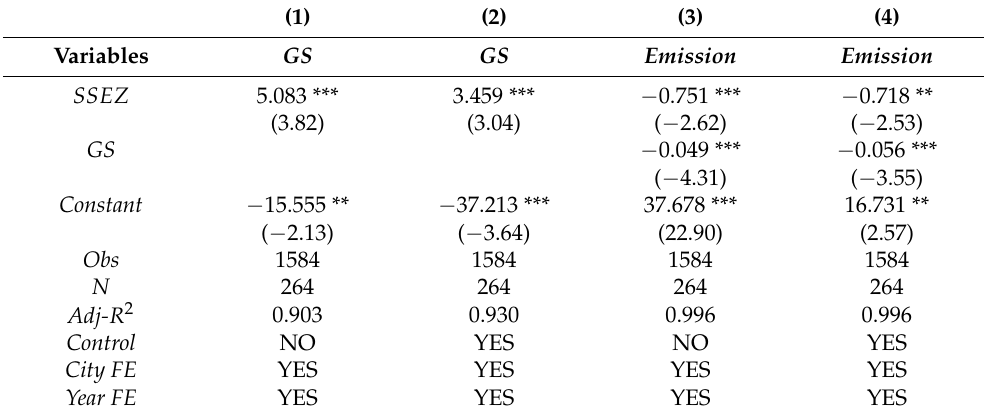
Table 4. Mechanism examination results.